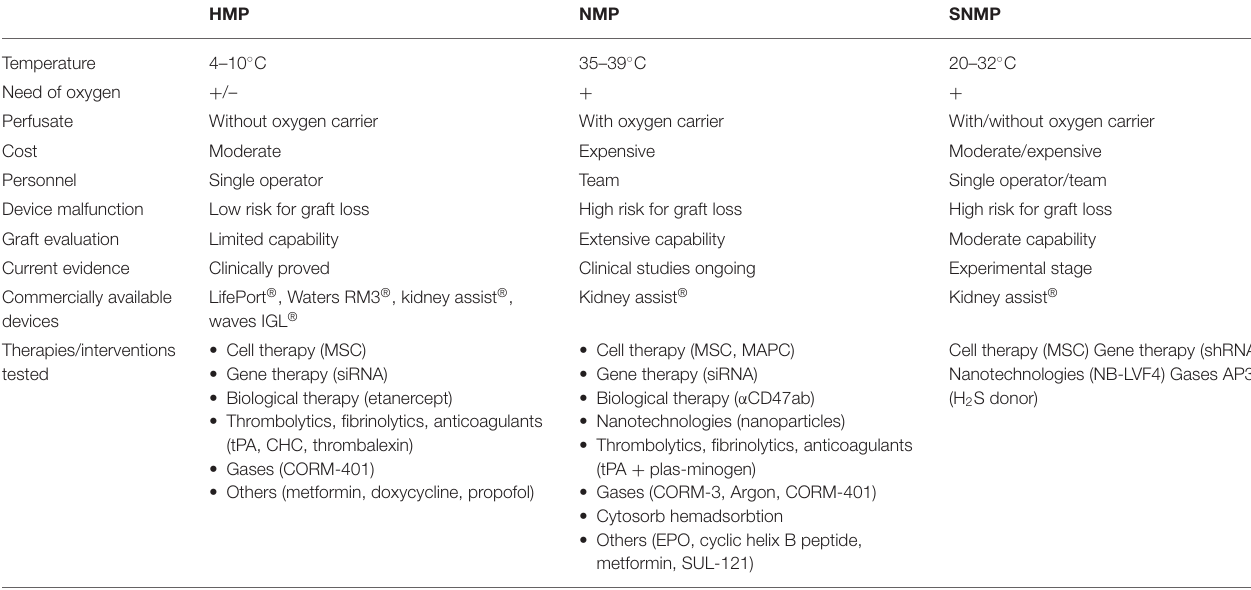
TABLE 1 | Comparison of different kidney machine perfusion